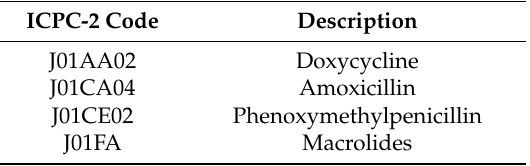
Table 5. Classification of antibiotic prescriptions by Anatomical Therapeutic Chemical